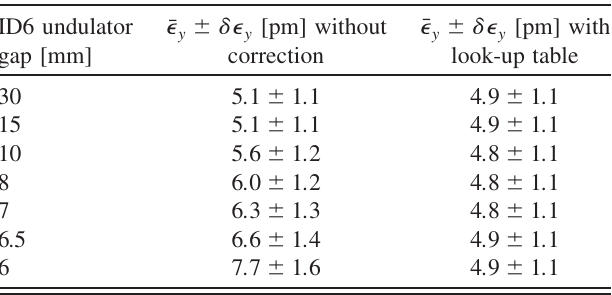
TABLE II. Mean vertical emittance (cid:2) (cid:3) sured against the vertical aperture of the ID6 in-vacuum undu- lator. The first column refers to the existing uncorrected setting, while the second was obtained after implementing correction look-up tables.